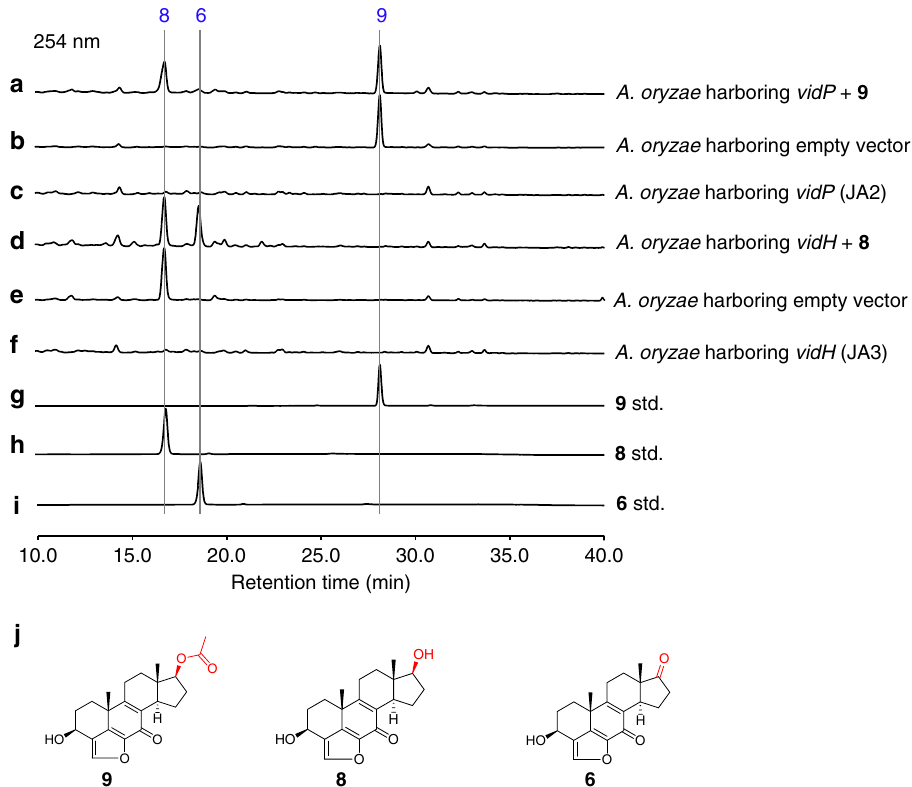
Fig. 6 HPLC analysis of feeding experiments. a A. oryzae harboring vidP (JA2) with 9 . b A. oryzae harboring empty vector with 9 . c A. oryzae harboring vidP . d A. oryzae harboring vidH (JA3) with 8 . e A. oryzae harboring empty vector with 8 . f A. oryzae harboring vidH . g )Standard (std.) of 9 . h Standard (std.) of 8 . i Standard (std.) of 6 . j Structures of compounds 9 , 8 , and 6 . The enzyme-mediated modi fi cation sites in individual reaction are marked by